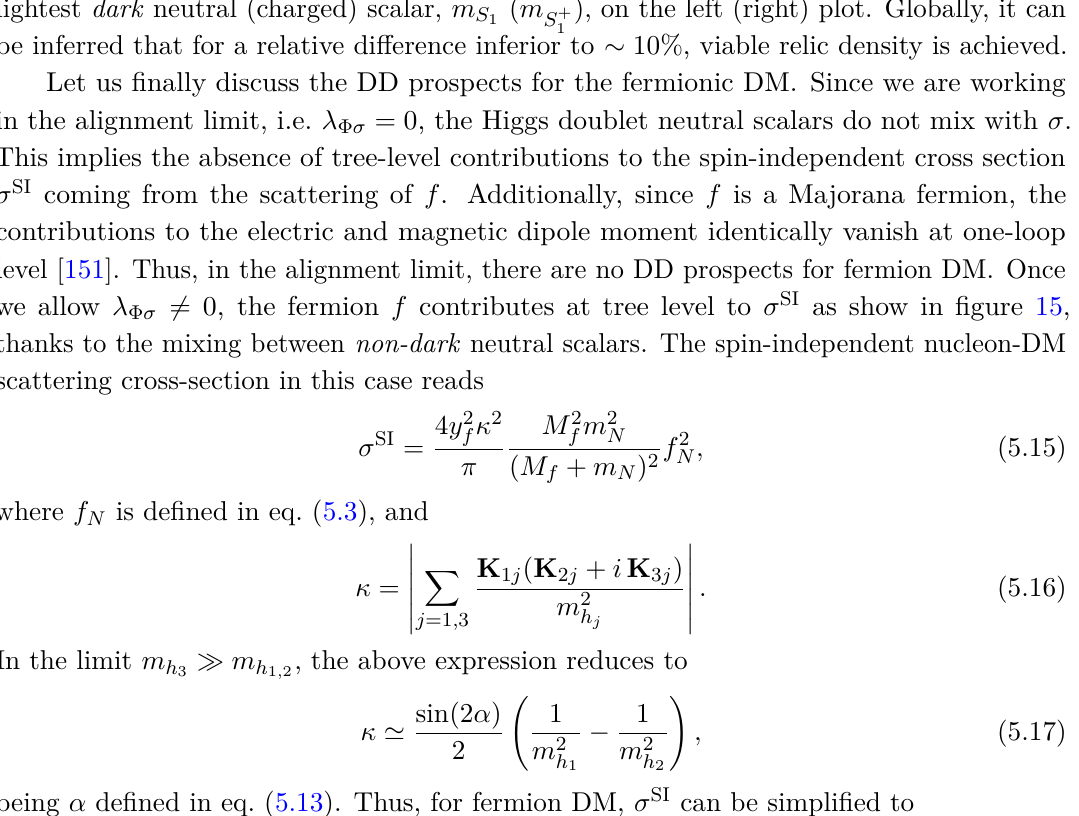
Figure 14 . Relic density Ω h 2 as a function of the relative difference between the DM mass M f and the lightest odd neutral (charged) scalar mass m same colour code as in figure 9 is being employed. Note that, all points in the plots above satisfy the LEP bounds on scalar masses [see eqs. (4.4) and discussion